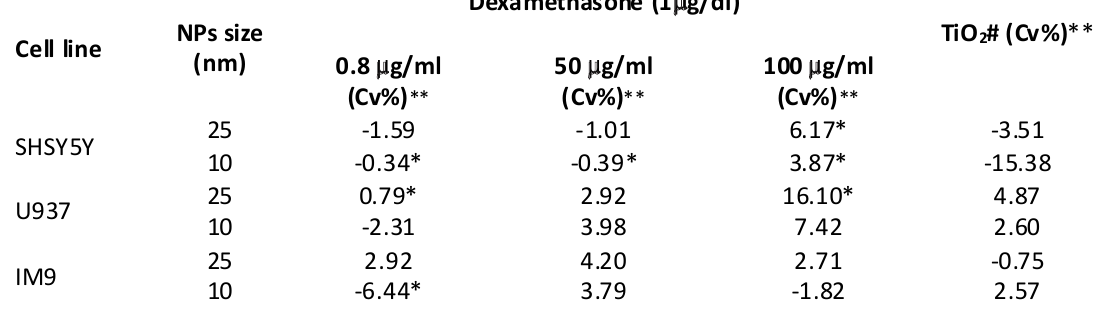
Table 5.: The effect of two different sizes of TiO vs. TiO -treated only 2 ** Increase in cell viability (per cent) at the end of the 24-hour incubation period. #The mean value of cell viabilities (per cent) for ten different concentrations (from 0.2 m g/ml to 100 m g/ml) of TiO NPs at the end of the 24-hour incubation period. 2 *p < 0.05; Dexamethasone treated group compared to mean value of cell